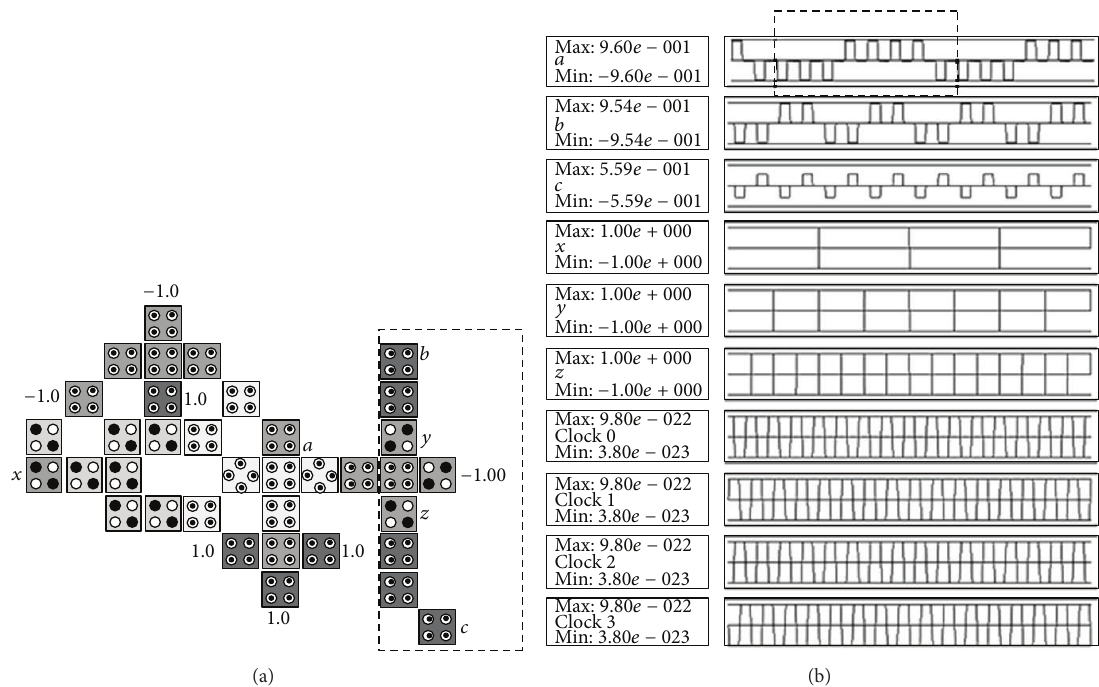
Figure 13: The proposed QCA for the Toffoli gate: (a) the layout where the added cells to the basic building block are highlighted with dashed line, (b) the simulation